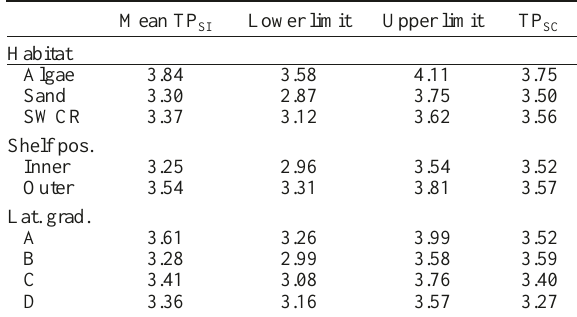
Table 4. – Trophic position of P. maculatus estimated through stable isotopes (TP ) and its upper and lower limits and stomach SI